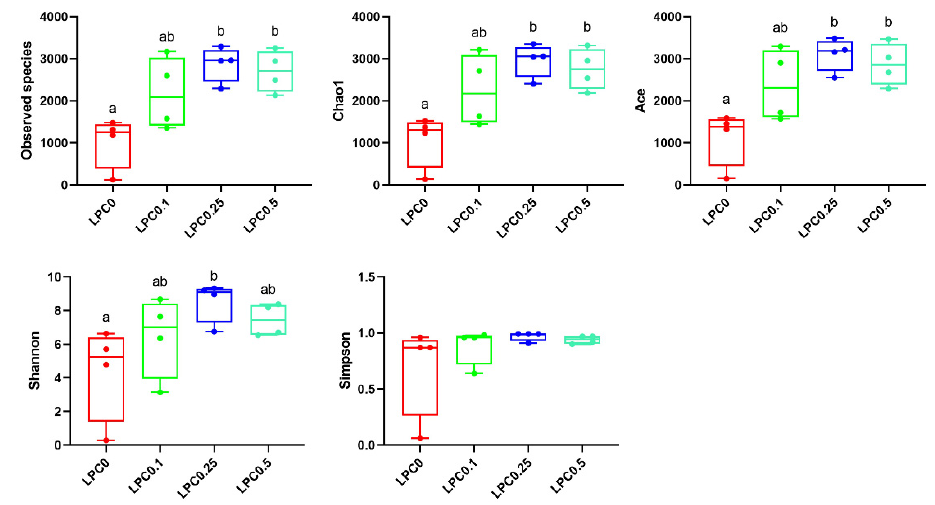
Figure 6. α diversity of the intestinal microbiota. Results were expressed as means ± S.E., and different superscript letters indicate significant differences ( p < 0.05).